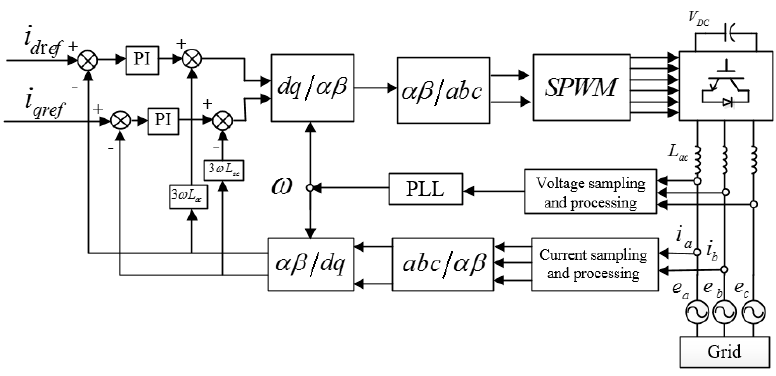
Figure 10. Overview control structure of DC/AC converter.